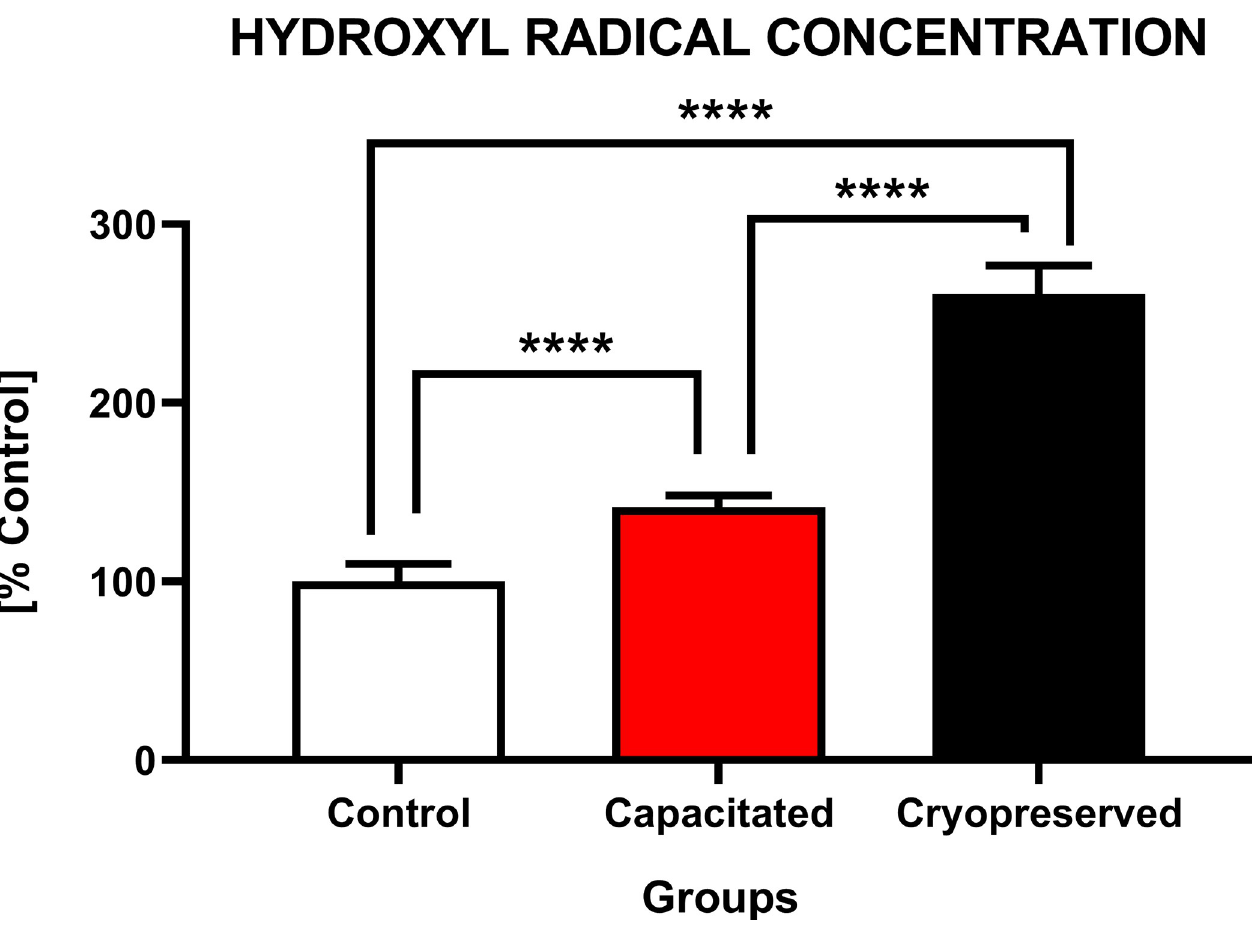
Fig 13. Intracellular production of hydroxyl radical of non-capacitated, in vitro capacitated and cryopreserved bovine spermatozoa. Each column presents the concentration (%) of hydroxyl radical by comparing all groups with each other ( ± SD). The level of significance was set at � P < 0.05; �� P < 0.01; ��� P < 0.001; ���� P <